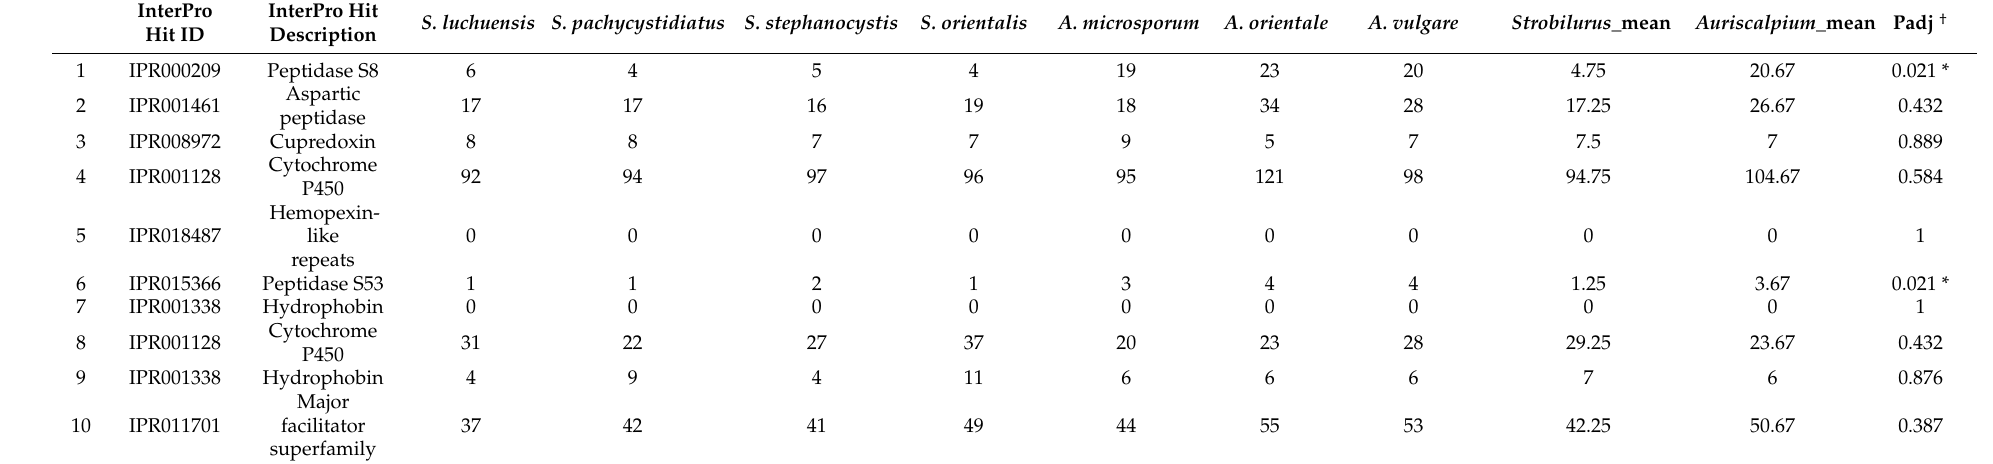
Table 2. Abundance and distribution of the top 10 groups of overexpressed genes in the presence of latex among the seven sequenced genomes in this study.